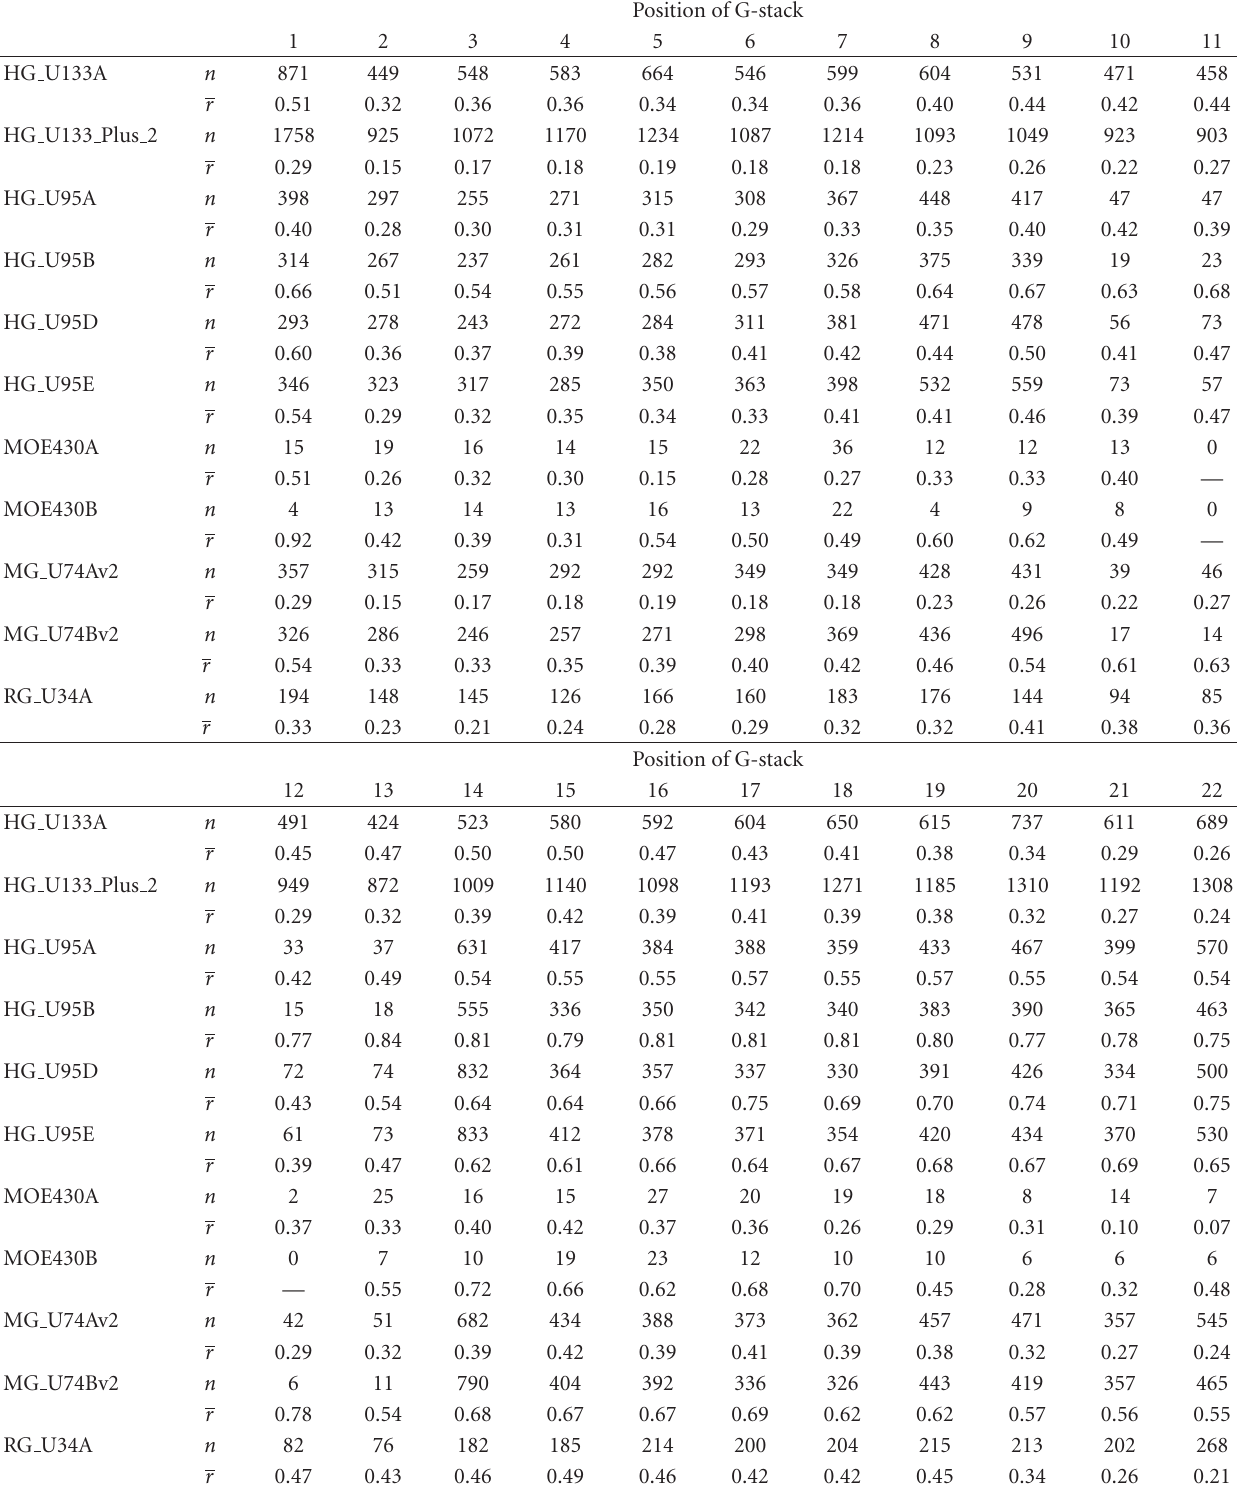
Table 2: In G-stack probes, the e ff ect of the position of G-stack on the average correlation coe ffi cient value, ( n is the number of a ff ected probes and r is the average correlation between these n